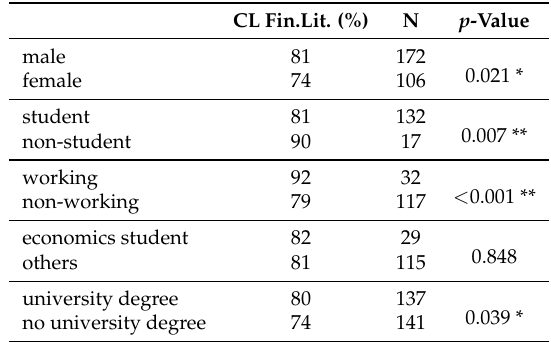
Table 9. Demographic characteristics and financial literacy as measured by the new Cumurovic-Lusardi scale (CL).